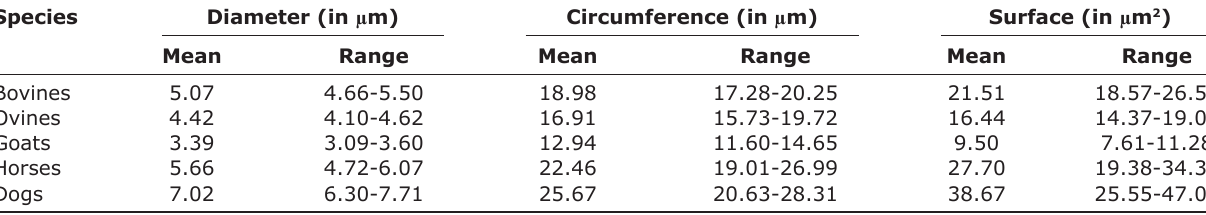
Table-7: Summary of new reference values of morphometric parameters of red blood cells in pets.